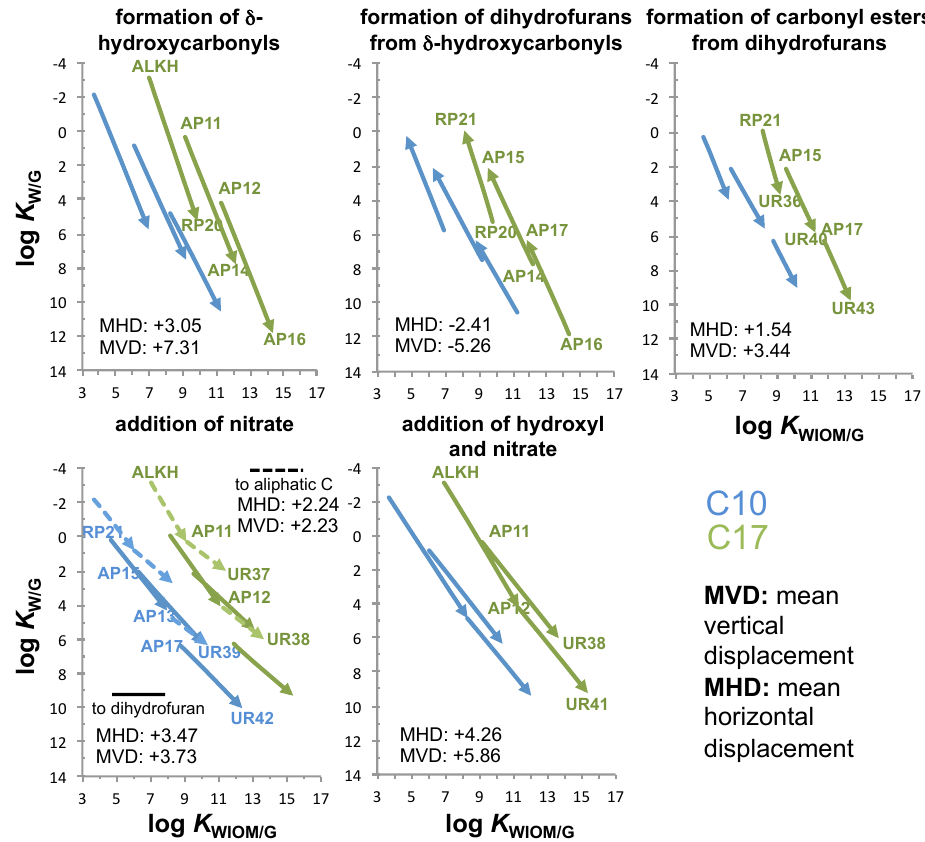
Figure 8. Displacement of chemicals in the partitioning space caused by transformations involved in the oxidation of n -alkanes with 10 (blue) and 17 (green) carbons using predictions of K WIOM / G and K W / G at 25 ◦ C obtained by ppLFER. Also given are the mean vertical displacement (MVD) and mean horizontal displacement (MHD).